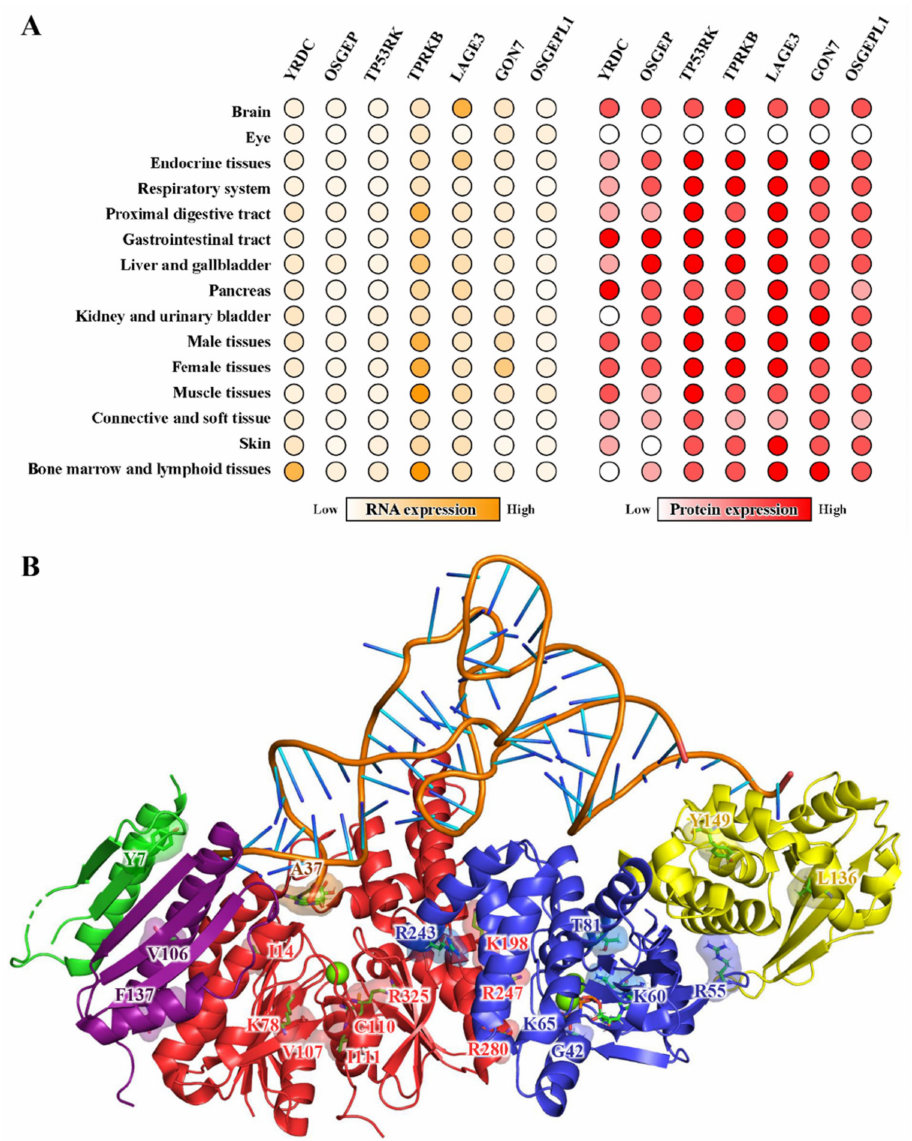
Figure 3. Expression patterns of human tRNA t 6 A-modifying enzymes and the pathogenic mutations of human KEOPS. ( A ). Transcriptomic and proteomic profiles of YRDC , OSGEP , TP53RK , TPRKB , LAGE3 , GON7 and OSGEPL1 in different organs and tissues of humans (Human Protein Atlas) [114,115]. Values were scaled and normalized to the highest that are coded in orange and red, respectively. Blank circles denote not determined. ( B ). The structural model of human KEOPS in complex with tRNA. The model was generated by aligning the crystal structure of M. jannaschii Cgi121–tRNA (PDB: 7KJT) onto a composite structural model of human KEOPS built using H. sapiens OSGEP–LAGE3–GON7 (PDB: 6GWJ) and H. sapiens TP53RK–TPRKB (PDB: 6WQX). The represented mutations associated with Galloway–Mowat syndrome are projected structures of osgep , tp53rk , tprkb , lage3 and gon7 , which are colored in red, blue, yellow, purple and green,